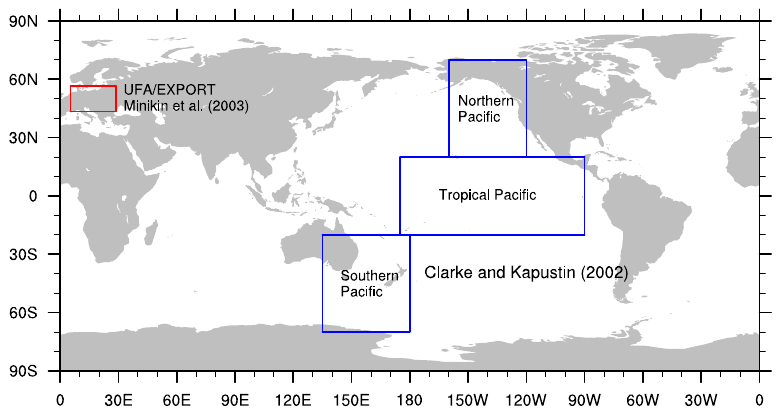
Fig. 8. The Pacific (blue) and European (red) regions in which the simulated aerosol number concentration profiles are compared against observations. See Sect. 5 for further information.